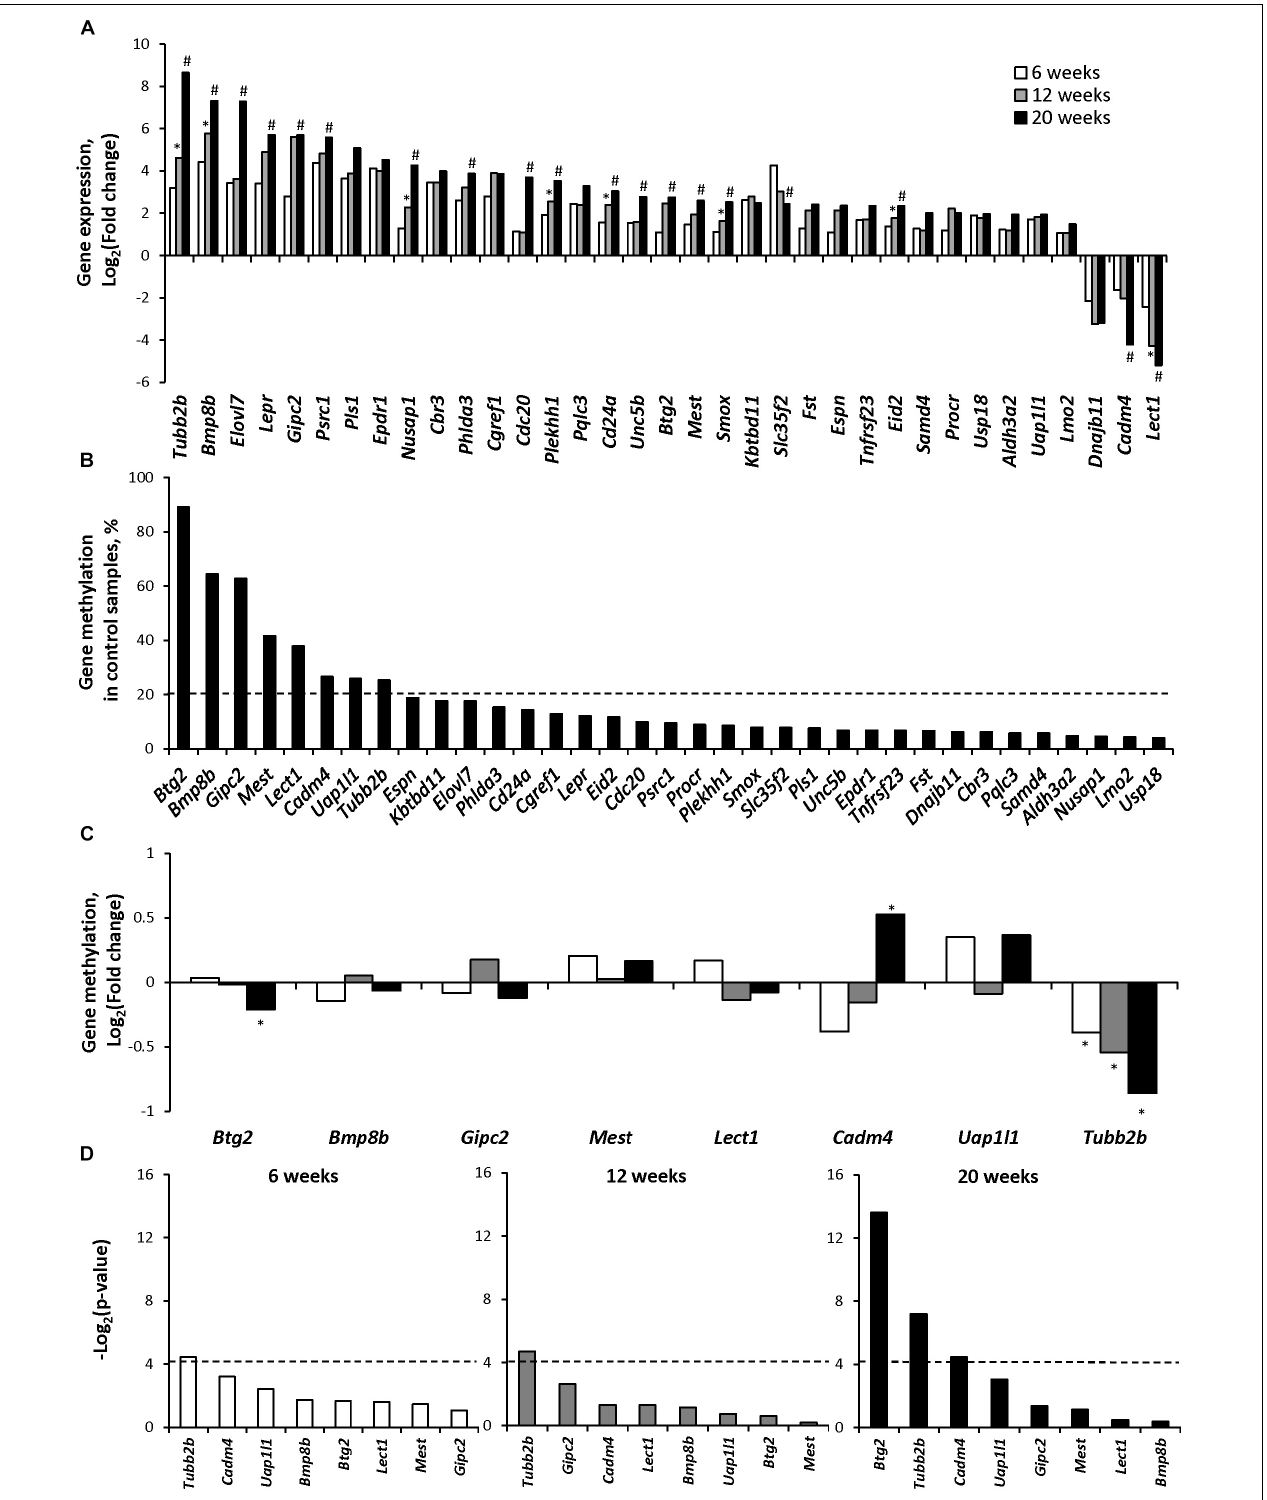
FIGURE 1 | Gene expression and gene-specific methylation of epigenetically regulated differentially expressed genes during NASH-associated liver carcinogenesis in STAM mice. (A) Expression of the selected epigenetically regulated genes at NAFL (6 weeks), NASH-fibrotic (12 weeks), and full-fledged HCC (20 weeks) stages of NASH-associated liver carcinogenesis. ∗ Denotes significantly expressed genes ( P < 0.05) in the livers of STAM mice at 12 weeks as compared to their expression at